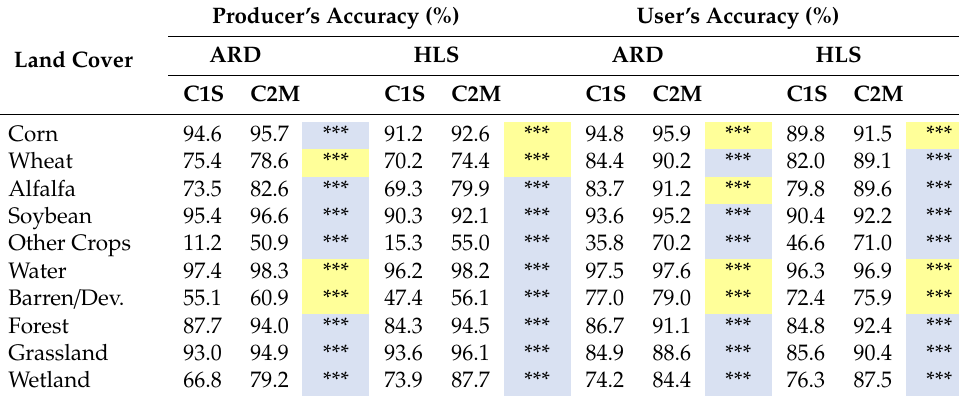
Table 6. Producer’s and user’s accuracies (in percent) of 2016 RFC models using C1S and C2M sample pools. Significance levels of the U test (C1S < C2M) across rows are indicated by ***, **, and * for p-values of less than 0.001, 0.01, and 0.05, respectively. NS stands for “not significant”. Results of the TOST equivalence tests across rows are highlighted in light blue for “not equivalent” and light yellow for “equivalent”.